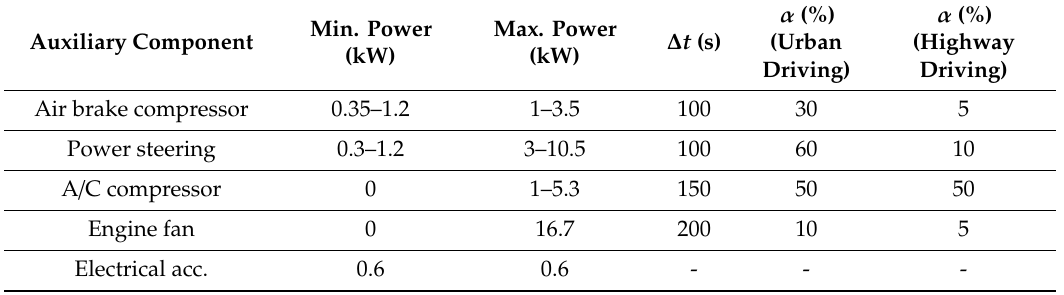
Table 3. Power and duty cycle parameters of the auxiliary loads in a conventional HD